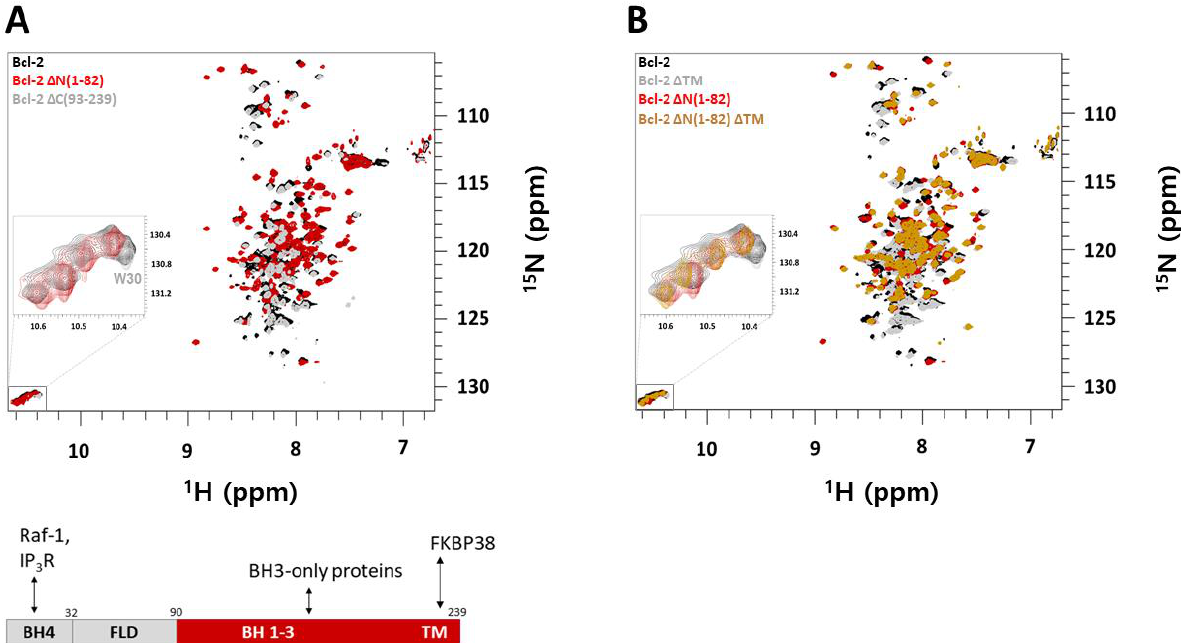
Figure 4. ( A ) Overlay of 1 H- 15 N-TROSY-HSQC NMR spectra (top) of Bcl-2 constructs in 5 mM DPC micelles in NMR buffer at pH 6: (black) 0.36 mM 15 N-labeled Bcl-2; (red) 0.4 mM 15 N-labeled Bcl-2 ∆ N(1–82); and (gray) 0.63 mM 15 N-labeled Bcl-2 ∆ C(93–239) at 310 K. Below is a schematic representation of the full length Bcl-2 sequence showing domain organization based on the function in its membrane. N-terminal BH4, FLD, C-terminal BH3-1, and N-terminal domains are known to interact with IP 3 R and Raf-1 proteins while C-terminal BH3-1 domains are known to interact with BH3-only proteins; interactions which are involved in apoptosis. The TM domain has been reported to be stabilized by the mitochondrial chaperone protein FKBP38 which actively translocate Bcl-2 from the cytosol to the MOM. ( B ) Overlay of 1 H- 15 N-TROSY- HSQC spectra showing Bcl-2 (black), Bcl-2 ∆ TM (gray), Bcl-2 ∆ N1 – 82 (red), and Bcl-2 ∆ N1- 82 ∆TM (brown) in 5 mM DPC micelles in NMR buffer at 310 K. Overlay of the spectra shows that the structure is retained. Truncation of N-terminal and flexible loop residues (1 – 82) results in less overlapped NMR spectra. The Figure inserts (zoomed boxes) show the tryptophan side-chain region of the respective NMR spectrum.